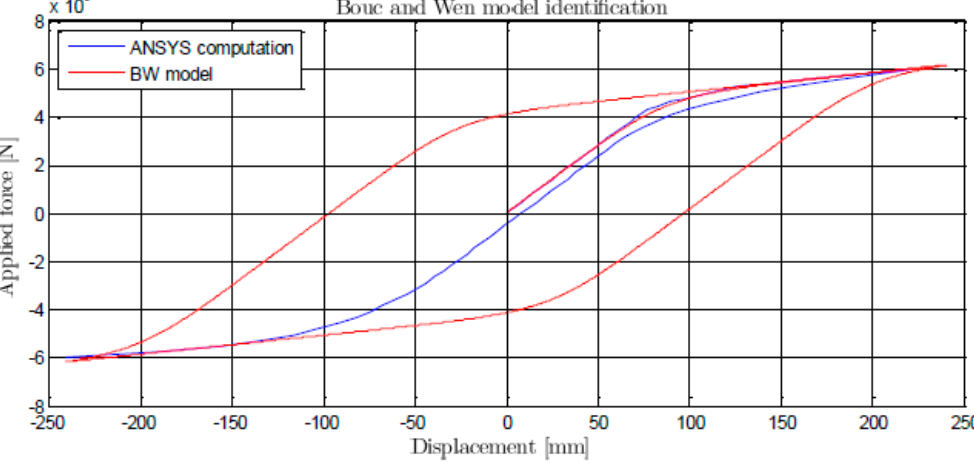
Figure 2: Comparison of the identified BW model with the ANSYS results (1 st attempt).